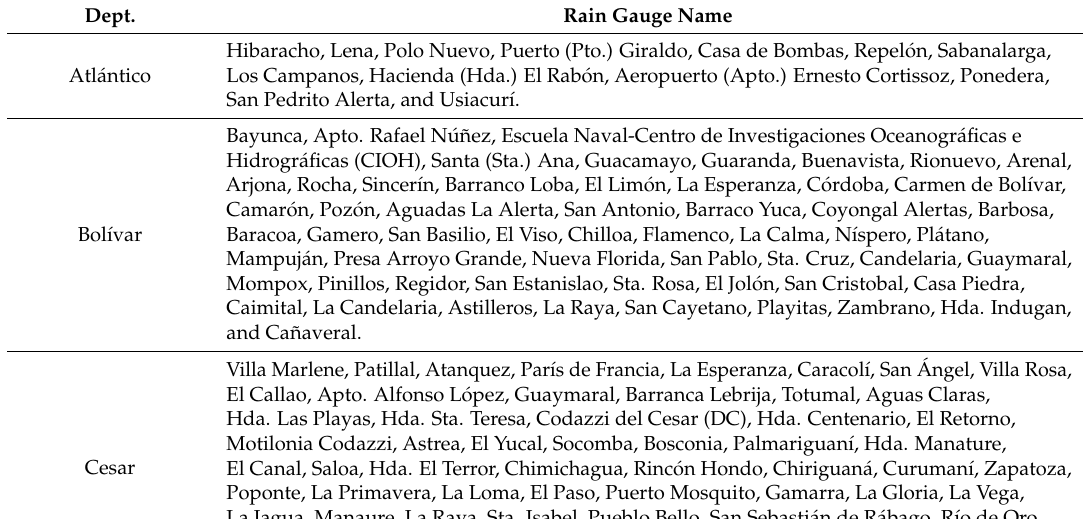
Table 2. Rain gauges of the area of